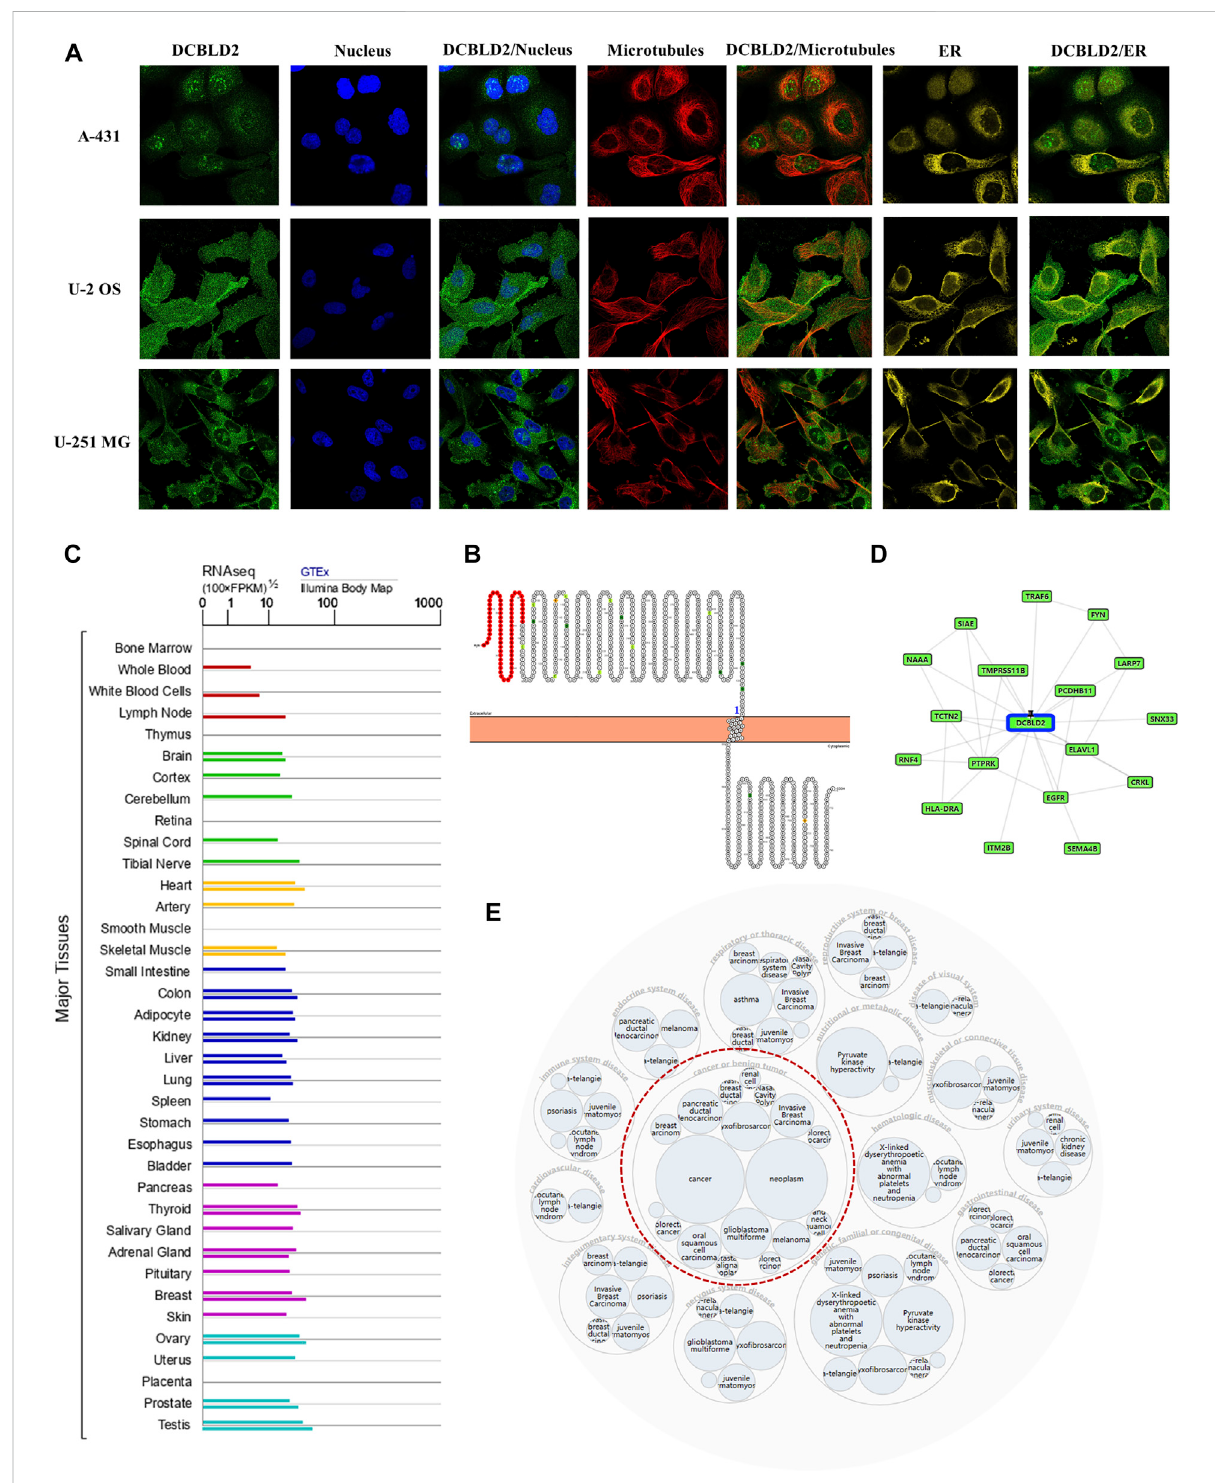
FIGURE 1 Cellular localization, topology, tissue expression of DCBLD2 and its correlation with diseases. (A) Immuno fl uorescence assay showed intracellular localization of DCBLD2 protein in A-431, U-2 OS, and U-251 MG cells as adopted from the HPA database. (B) DCBLD2 protein topology showing transmembranelocalization. (C) The mRNA expression level of DCBLD2 in all normal human tissues as adoptedfrom the TCGA data. (D – E) Network of potential binding proteins of DCBLD2 (D) and the DCBLD2 -related disease (E)